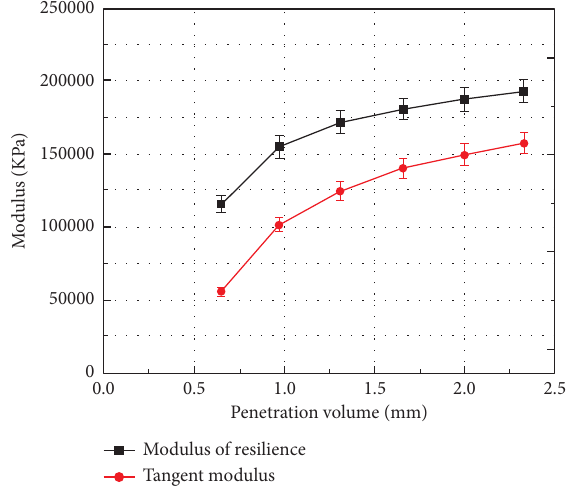
Figure 9: Relationship between resilience modulus and tangent modulus of FSW. The error bars represent the standard deviation of measurements for 18 particles in two separate sample runs ( n �